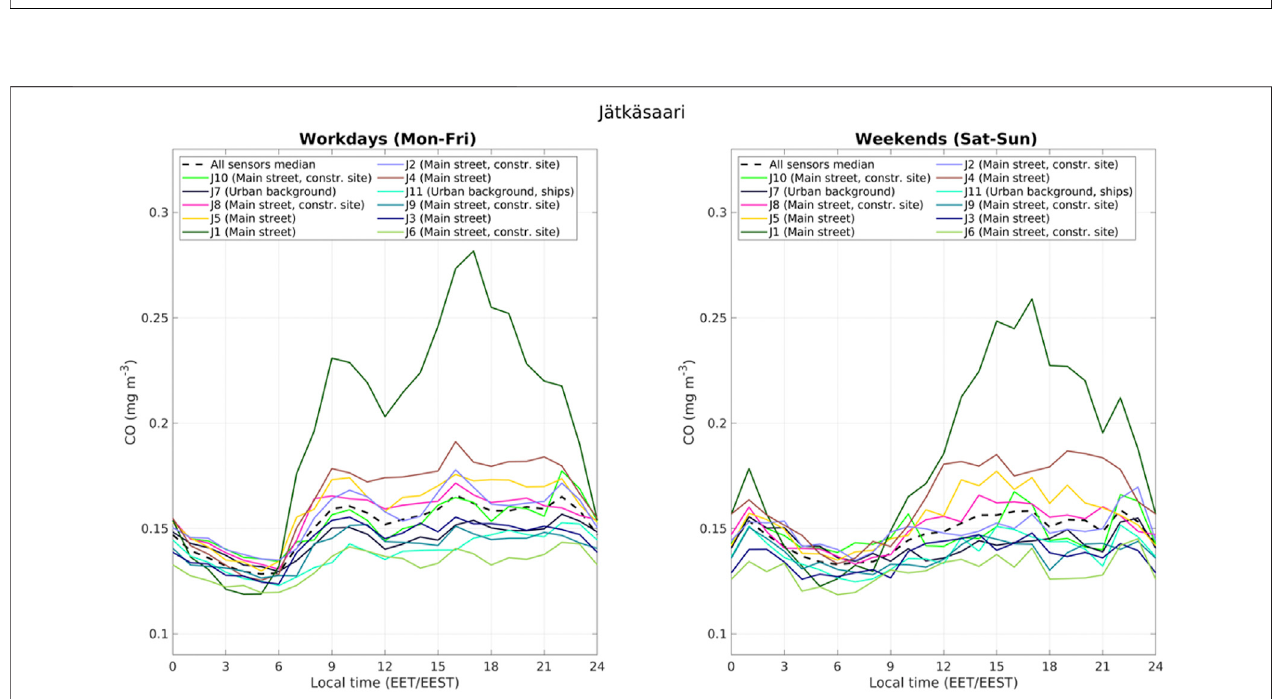
FIGURE 8 | Median diurnal cycles of CO during 5-month period (1.8.-31.12.2020) for sensors located in Jätkäsaari (left) workdays (Mon-Fri) and (right) weekends (Sat-Sun). Black dashed line shows median diurnal cycle calculated for all data from that location.